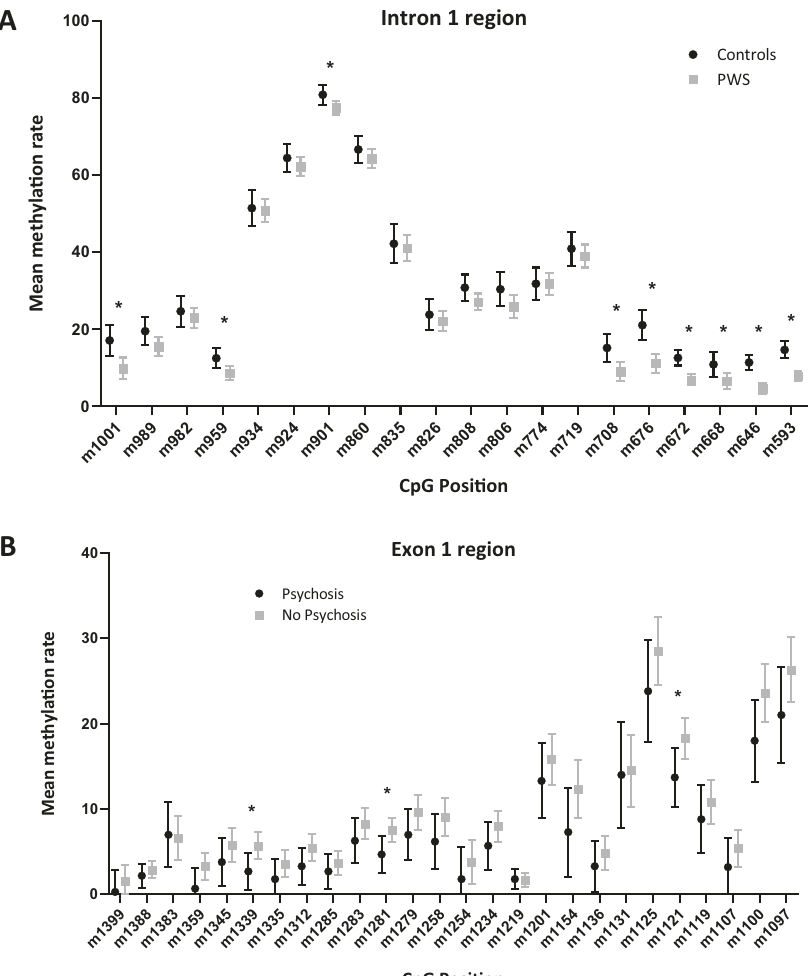
Fig. 2 Mean methylation rates of the OXTR gene in PWS subjects and controls. A Mean methylation rates of PWS subjects compared to controls in the intron 1 region. CpGs where signi fi cantly lower methylation rates were detected in PWS subjects compared to controls are indicated by an asterisk. The graph shows mean values and SEMx2 values. B Mean methylation rates of PWS males with and without history of psychosis in the exon 1 region. CpGs where signi fi cantly lower methylation rates were detected in PWS males with psychosis compared to those without psychosis are indicated by an asterisk. The graph shows mean values and SEMx2